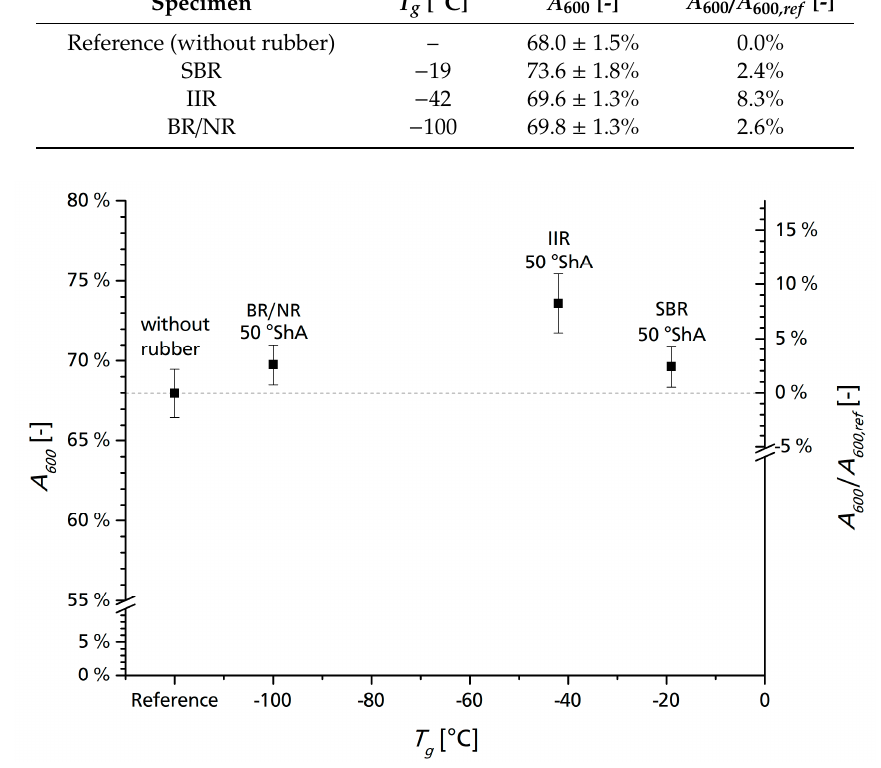
Figure 10. Energy absorption during ballistic impact experiments for the configurations with different rubbers. All three rubber compounds possess the same hardness to decrease potential influences besides glass transition and maximized damping.